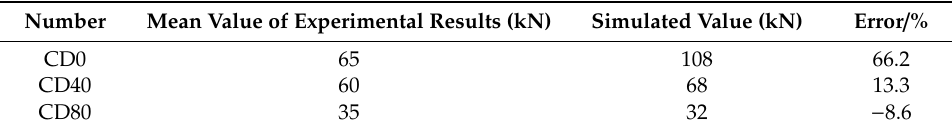
Table 8. Buckling loads of various honeycomb panels.